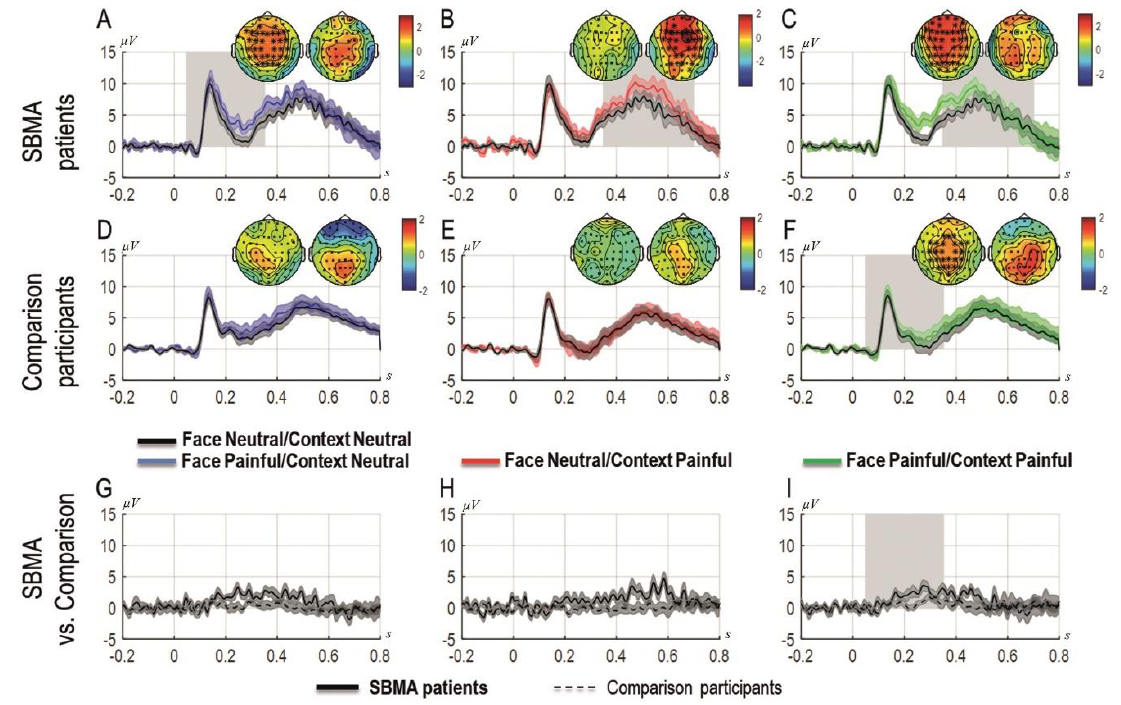
Figure 3. Grand-averages of ERPs at cluster sites for patients with SBMA and for controls separately and compared, for painful faces preceded by neutral contexts ( A , D , G ), for neutral faces preceded by painful contexts ( B , E , H ) and for painful faces preceded by painful contexts ( C , F , I ). Topographies are shown for each time window panel A to F (the left topography shows the scalp distribution of the activity in the 0–350 ms time-window; the right topography shows the scalp distribution of the activity in the 350–700 ms time-window). Asterisks represent the sites that form a cluster; the ERPs are plotted as the average of the activity in the significant cluster. The black dots represent the time-points with significant effects. Shades represent standard errors. Panels G, H, I represent differential responses between the conditions represented on the upper panels for patients with SBMA and controls.